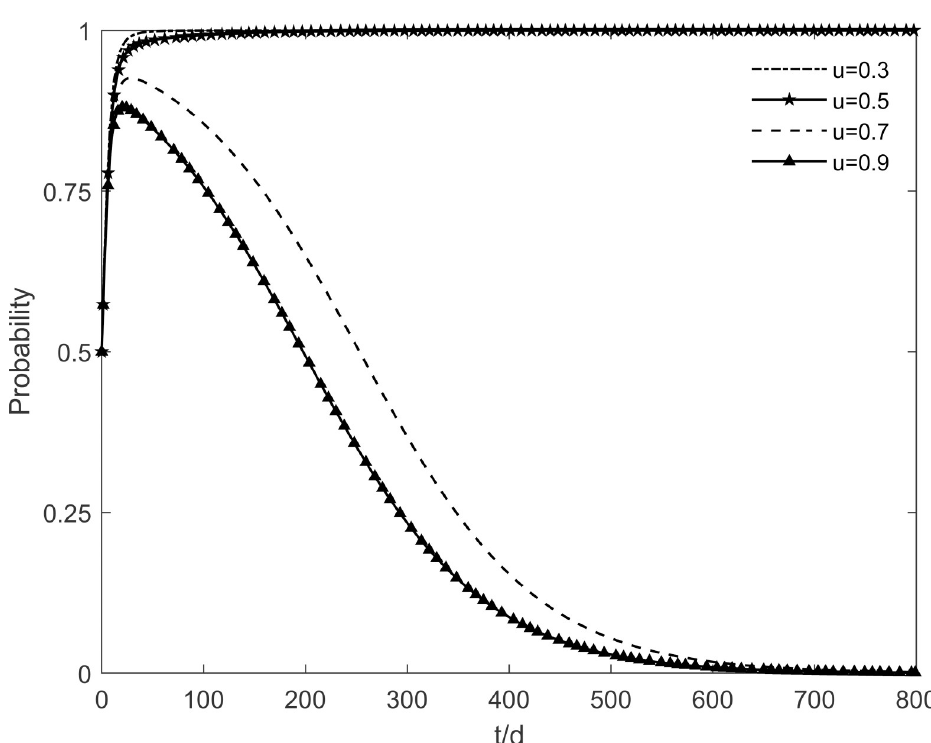
Fig 6. The impact of u on the government’s strategic choices.